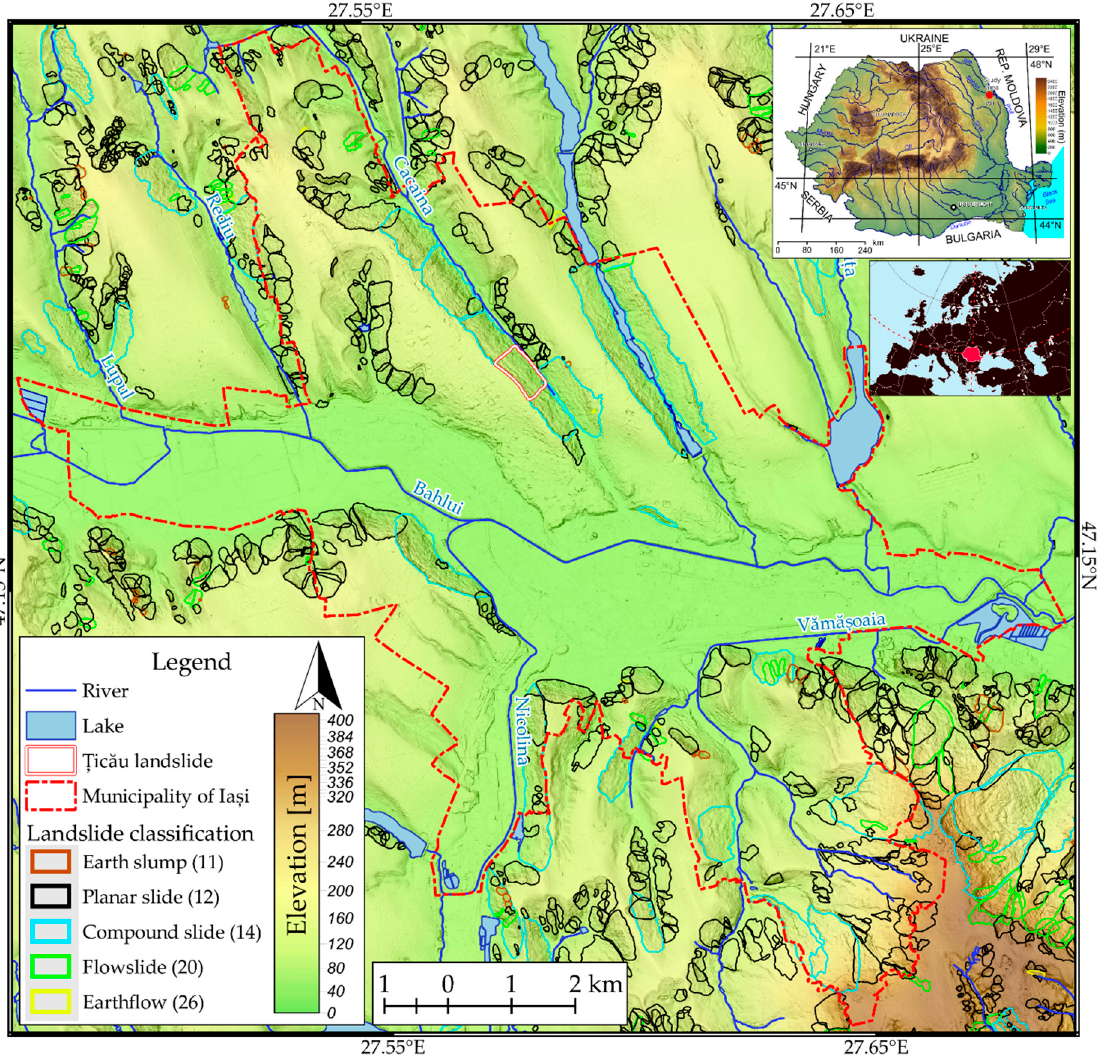
Figure 1. Location of Ia ș i Municipality (Northeastern Romania) and its terrain morphology. The landslide inventory is from [62], and the numbers in parentheses represent the landslide type based on the classification of [63]. (high-resolution image is available at https://doi.org/10.6084/m9.figshare.14915103.v2).